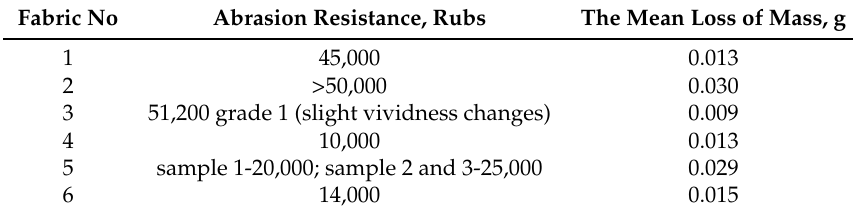
Table 2. The abrasion resistance test results—standard